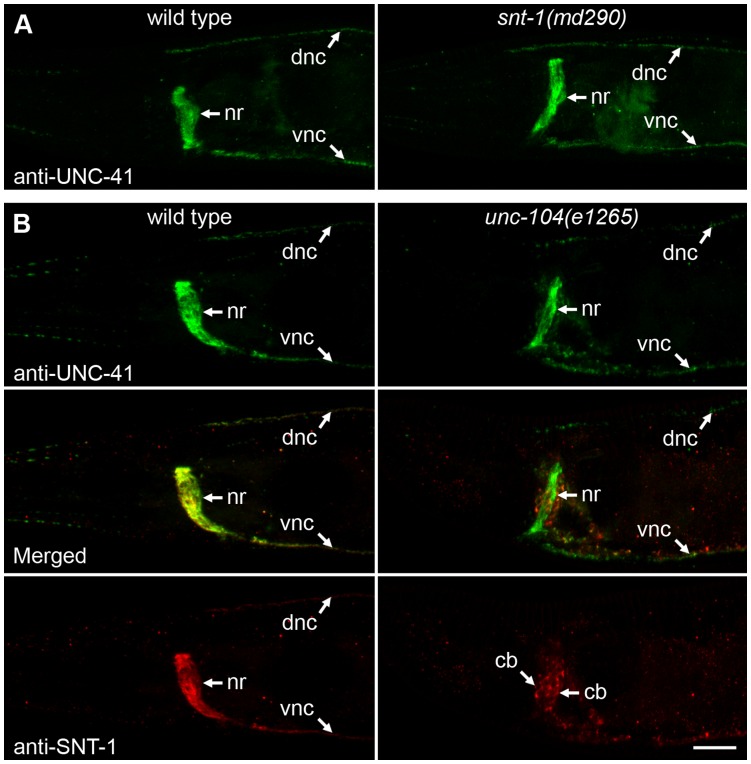
(A) Localization of UNC-41 is independent of synaptotagmin.Wild-type and snt-1(md290) young adult hermaphrodites were stained with antibodies to UNC-41. In both wild-type and mutant animals, UNC-41 is specifically associated with synaptic regions, including the nerve ring (nr) and dorsal (dnc) and ventral (vnc) nerve cords. (B) Synaptotagmin (SNT-1) but not UNC-41 requires the synaptic vesicle kinesin UNC-104 for transport to synapses. Wild-type and unc-104(e1265) animals were stained with antibodies to UNC-41 (green) and SNT-1 (red). Synaptotagmin is mislocalized to neuronal cell bodies (cb) and is no longer observed at synapses in the dorsal and ventral nerve cords in unc-104(e1265), whereas UNC-41 is still trafficked to synaptic regions. Slight accumulation of UNC-41 in neuronal cell bodies is also observed in unc-104 mutants. All images are of head regions, anterior is to the left, ventral is down, and the scale bar is 10 µm.